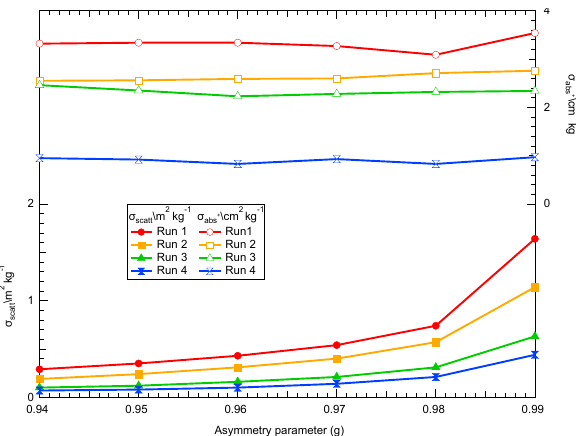
Figure 11. Variation in absorption cross section σ + upper, non-filled markers) and scattering cross section σ scatt (m 2 kg − 1 ; lower, filled symbols) owing to variation in the asym- metry parameter at 400nm. Note that the scatter in the values of σ + is due to the fitting process abs